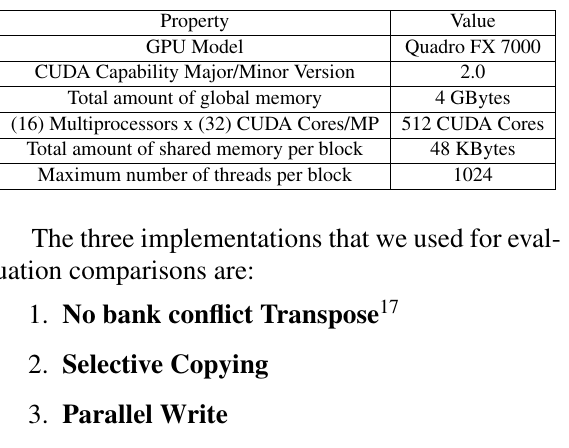
Table 1: GPU Specification